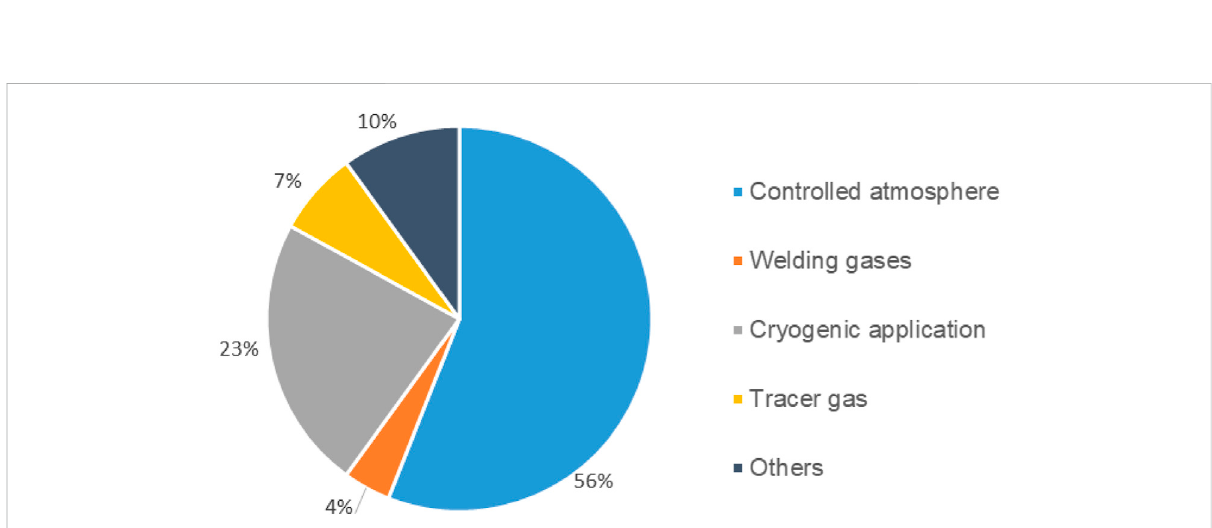
FIGURE 6 Helium consumption structure in China in 2020 (Source: General Administration of Customs) (Li et al.,